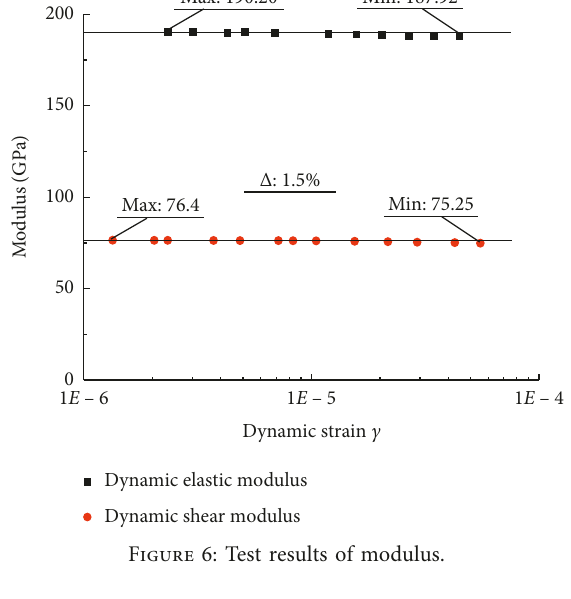
Figure 6: Test results of modulus.